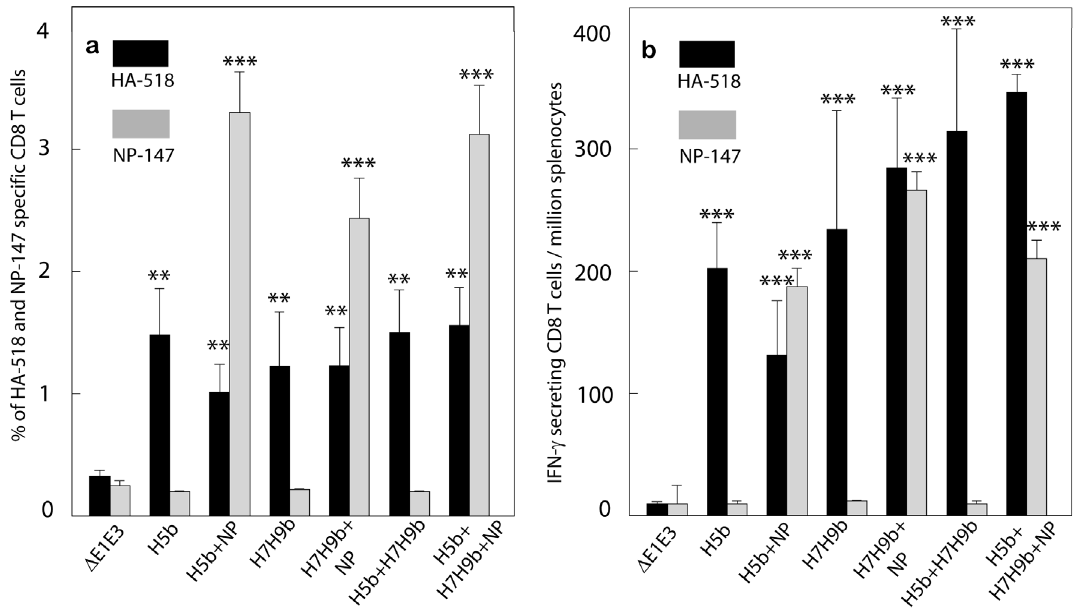
Figure 5. HA518 and NP147 epitope-specific CD8 + T cells and ELISpot measurements of IFN- c expression in spleen cells of vaccinated mice. Mice (7 animals/group) were immunized with H5b, H7H9b, H5b + H7H9b, H5b + NP, H7H9b + NP, H5b + H7H9b + NP or D E1E3 twice at four-week intervals. At four weeks after booster inoculation, the animals were euthanized, and the spleens were collected for the evaluation of HA- specific and NP-specific CMI responses using pentamer staining (a) and IFN- c -ELISpot assay (b) as described under Materials and Methods. The data represent mean 6 standard deviation (SD) from 7 animals/group. **; P , 0.010 and ***; P # 0.005 compared to D E1E3. H5b, HAd-1203HA-05HA; H7H9b, HAd-H7HA-H9HA; H5b + H7H9b; HAd-1203HA-05HA + HAd-H7HA-H9HA; H5b + NP, HAd-1203HA-05HA + HAd-NP; H7H9b + NP, HAd-H7HA-H9HA + HAd- NP; H5b + H7H9b + NP, HAd-1203HA-05HA + HAd-H7HA-H9HA + HAd-NP; D E1E3, HAd- D E1E3. doi:10.1371/journal.pone.0062496.g005 PLOS ONE |